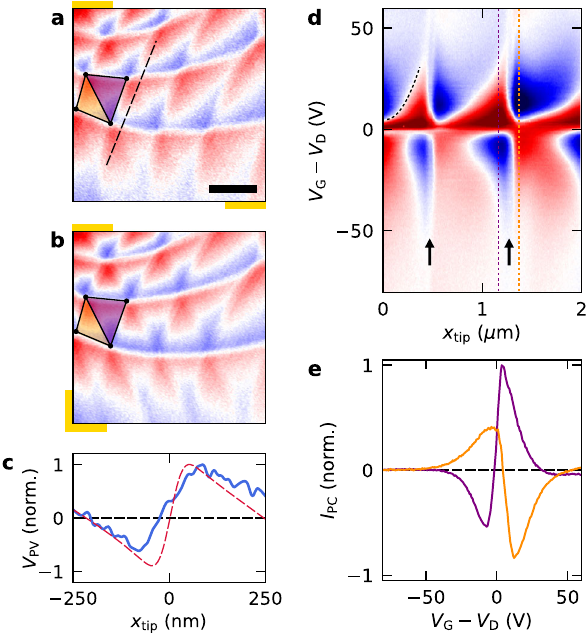
Fig. 2 Photoresponse in the moiré unit cell of mTBG. a Zoomed map of measured photovoltage V PV in the same sample presented in Fig. 1 (corresponding to the area with the largest domains in Fig. 1d), measured at excitation energy E = 117 meV and carrier density n ~ 1 × 10 12 cm − 2 . The map is normalised by the maximum measured V PV . Colour code: blue: − 1, red: + 1. The yellow/purple shaded triangles correspond to those in Fig. 1c. The gold annotations illustrate roughly the relative position of contacts used for measuring voltages. Length of scale bar: 500 nm. b Same as a but for a different choice of contacts (gold annotations) measured simultaneously. c Line-cut across a horizontal domain wall in b (blue), together with a line trace of the simulated pro fi le in Fig. 3g (dashed red). d Photocurrent as a function of gate-voltage V G (with respect to the position of the Dirac point V D ) measured for a line trace that crosses several domain walls (see black dashed line in a ). Black arrows mark the position of observable domain walls for this choice of contacts. The gate voltages correspond to carrier densities within roughly ±6 × 10 12 cm − 2 . e Gate-voltage response along the two line-cuts highlighted in d , on two opposite sides of the domain